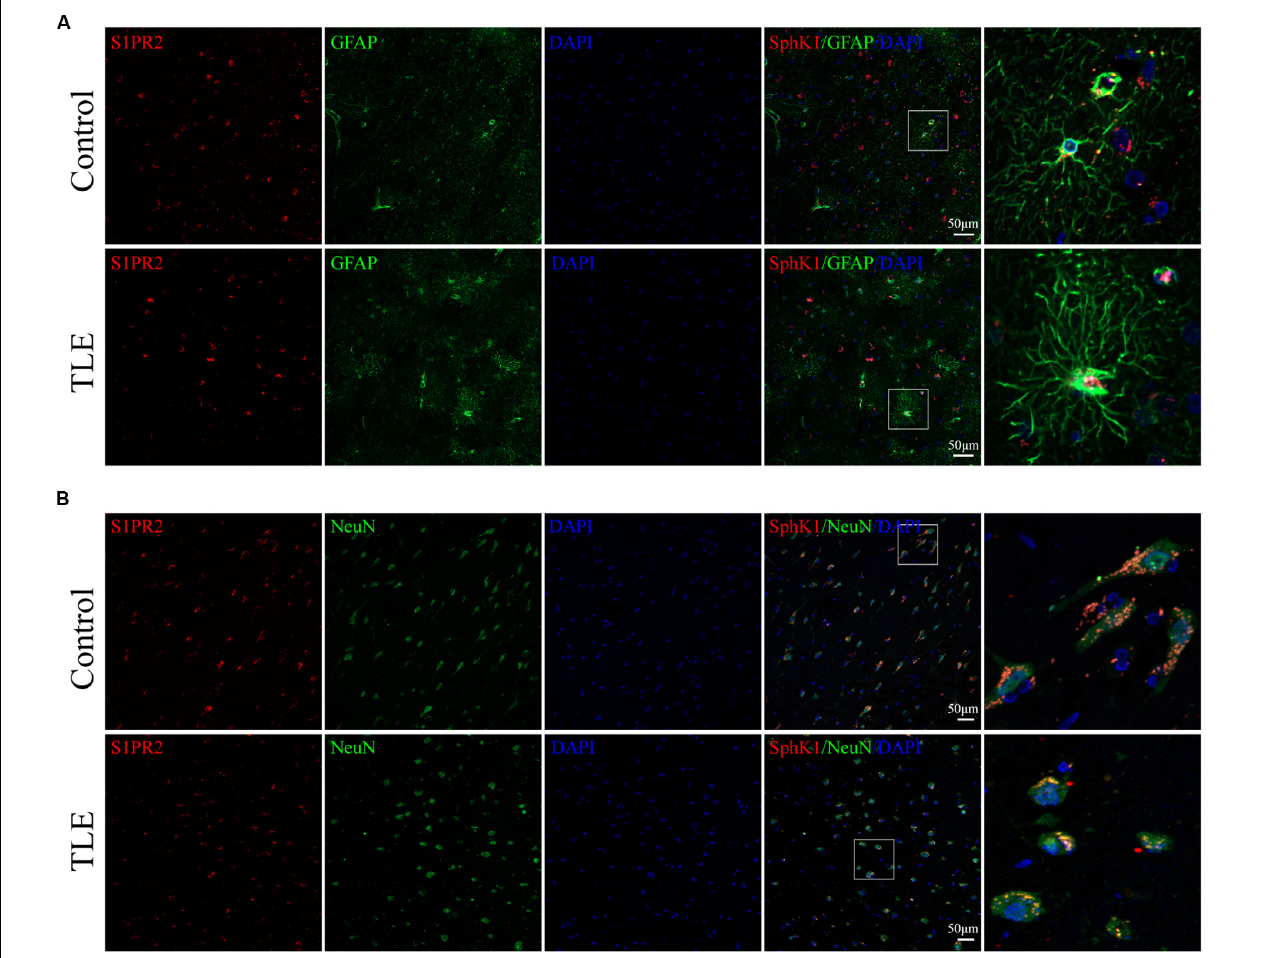
FIGURE 9 | Cellular localization of S1PR2 in temporal cortex tissues from patients with drug-resistant TLE patients. ( A , left) Confocal images showing co-localization of S1PR2 and DAPI in astrocytes. ( A , right) Enlarged view of indicated co-localization between S1PR2 with astrocytes. ( B , left) Confocal images showing co-localization of S1PR2 and DAPI in neurons. ( A , right) Enlarged view of indicated co-localization between S1PR2 with